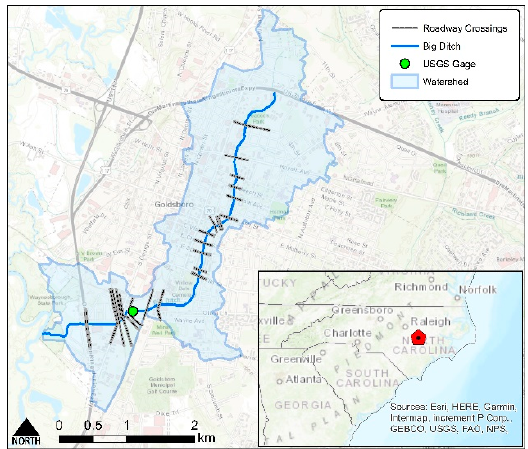
Water 2020 , 12 , x FOR PEER REVIEW